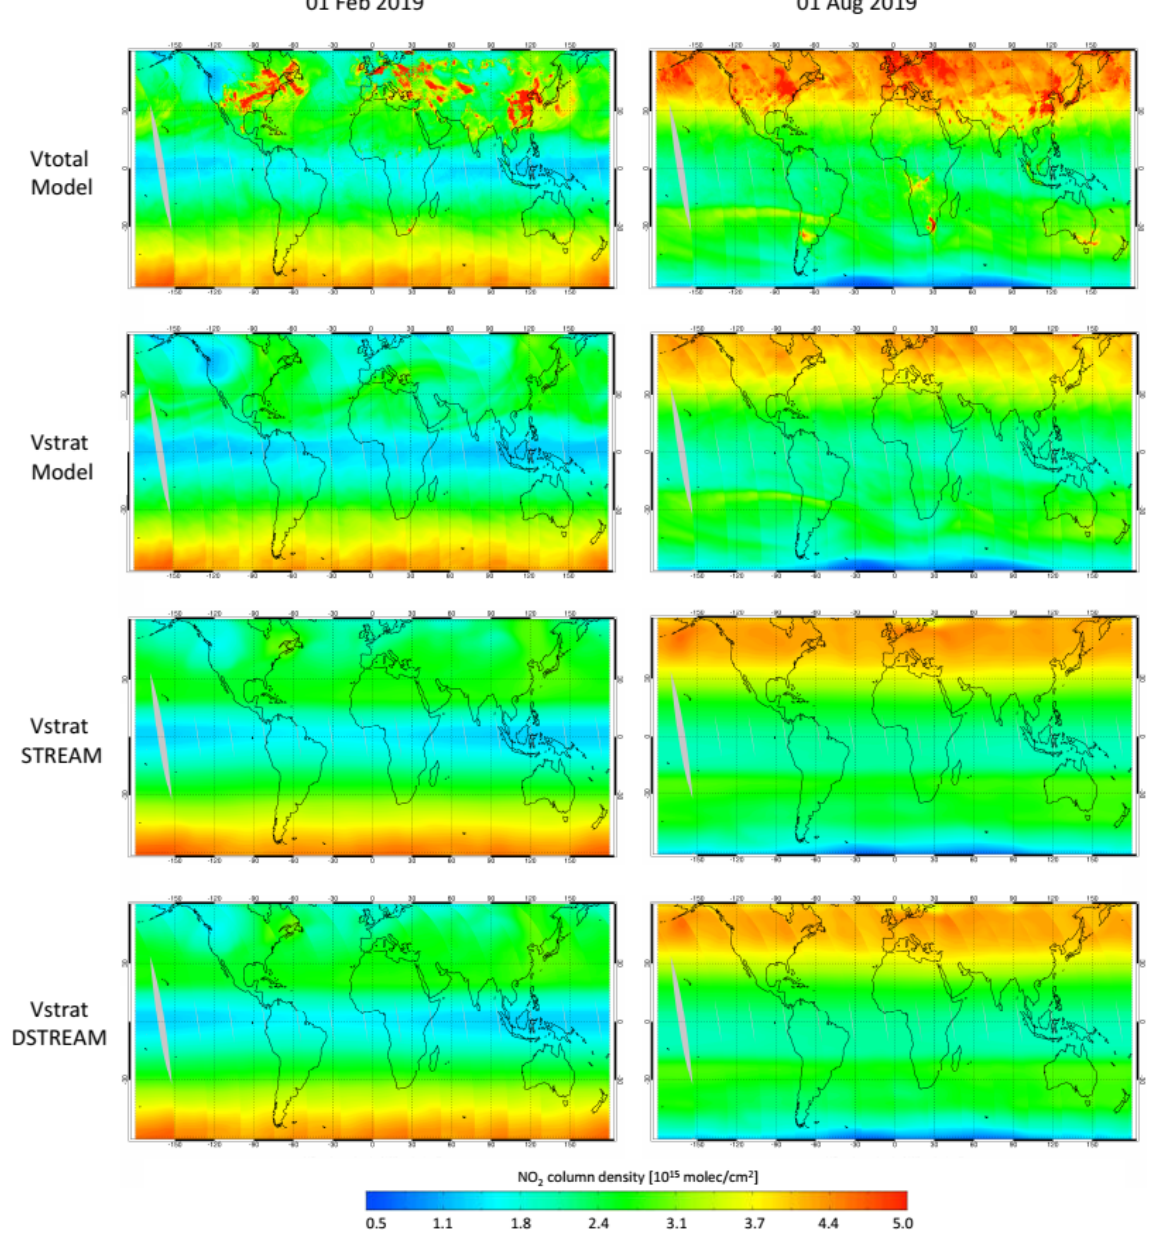
Figure 4. Synthetic total NO 2 columns, a priori stratospheric NO 2 columns from IFS(CB05BASCOE), and estimated stratospheric NO 2 columns from STREAM and DSTREAM on 1 February and 1 August